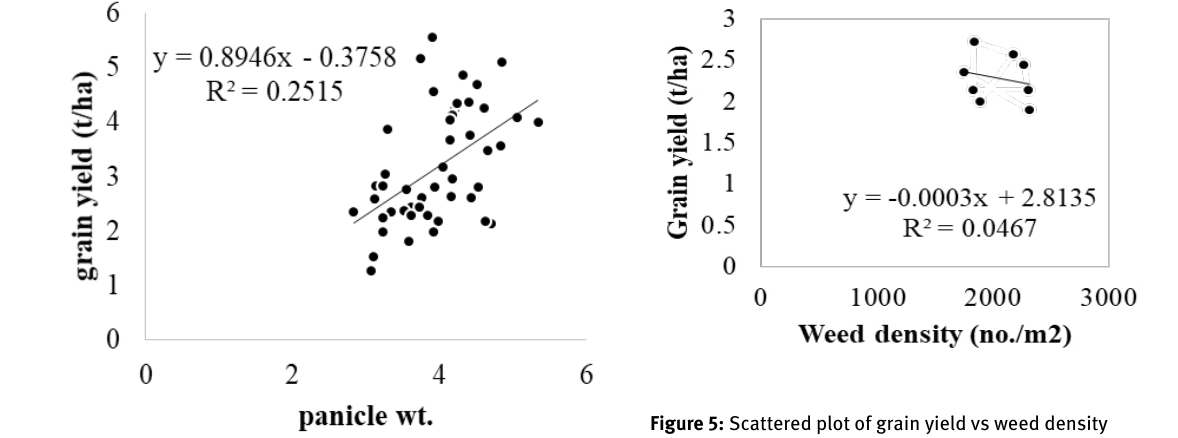
Figure 5: Scattered plot of grain yield vs weed density